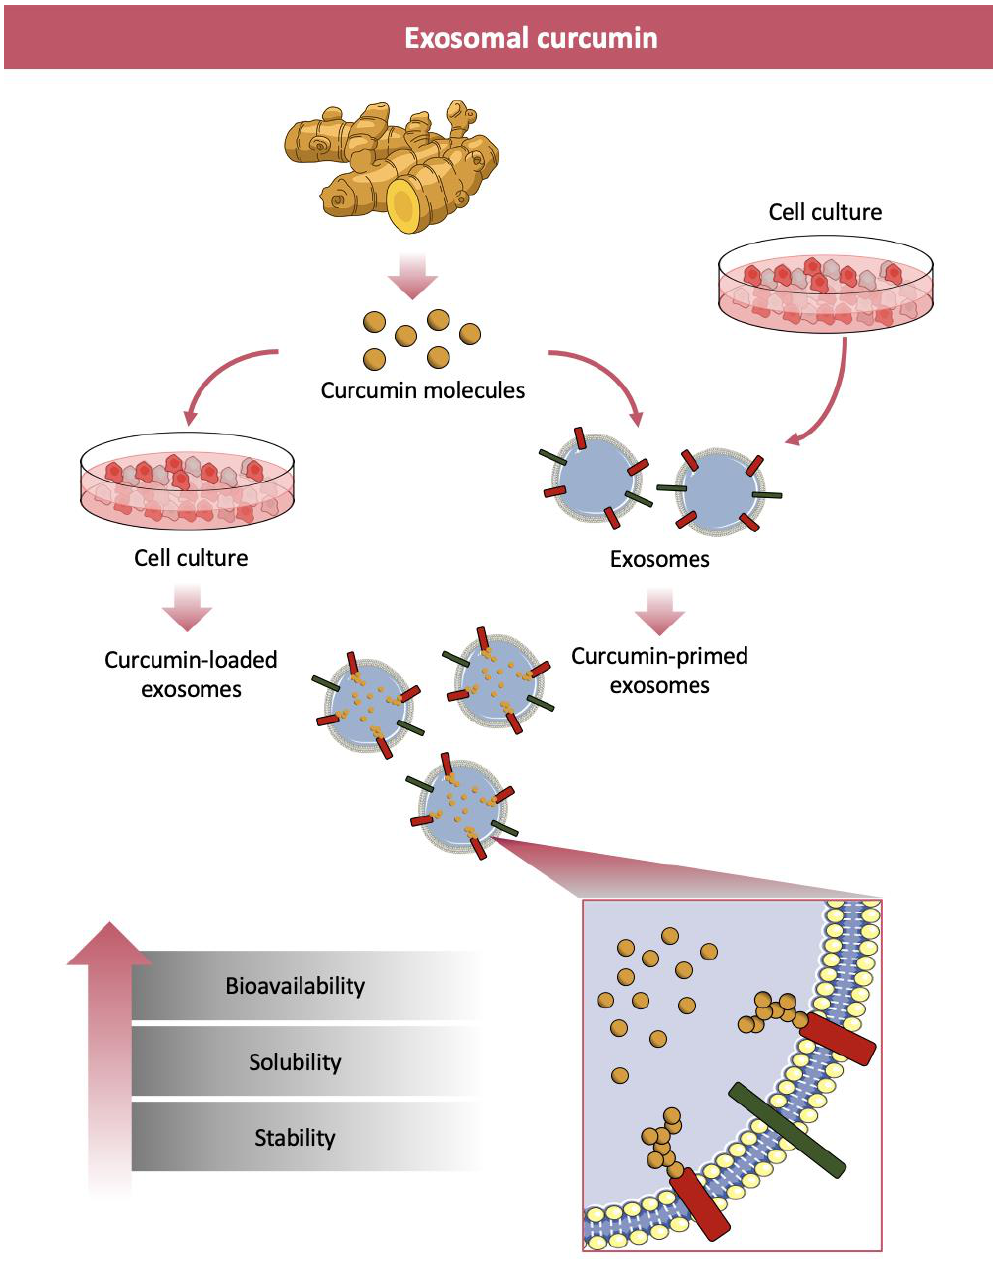
Figure 3. Synthesis of exosomes-loaded and exosomes-primed curcumin and benefits in terms of bioavailability, solubility and stability achieved in curcumin delivery.